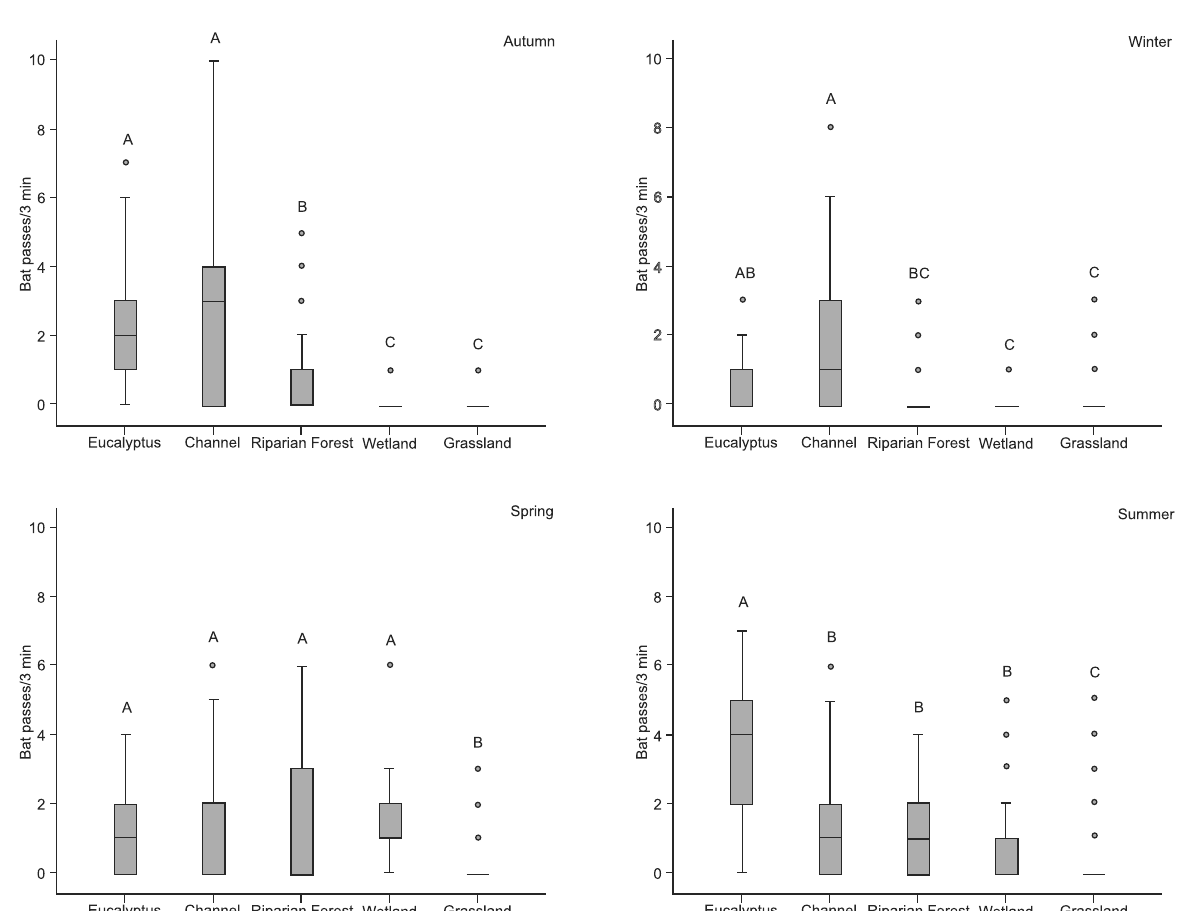
Figure 9. Box plot of the number of bat passes/3 min recorded with a bat detector in each habitat type in different seasons, from April 2009 to March 2010, in the grasslands of southernmost Brazil. Different letters indicate significant differences at the 0.005 probability level (with Bonferroni